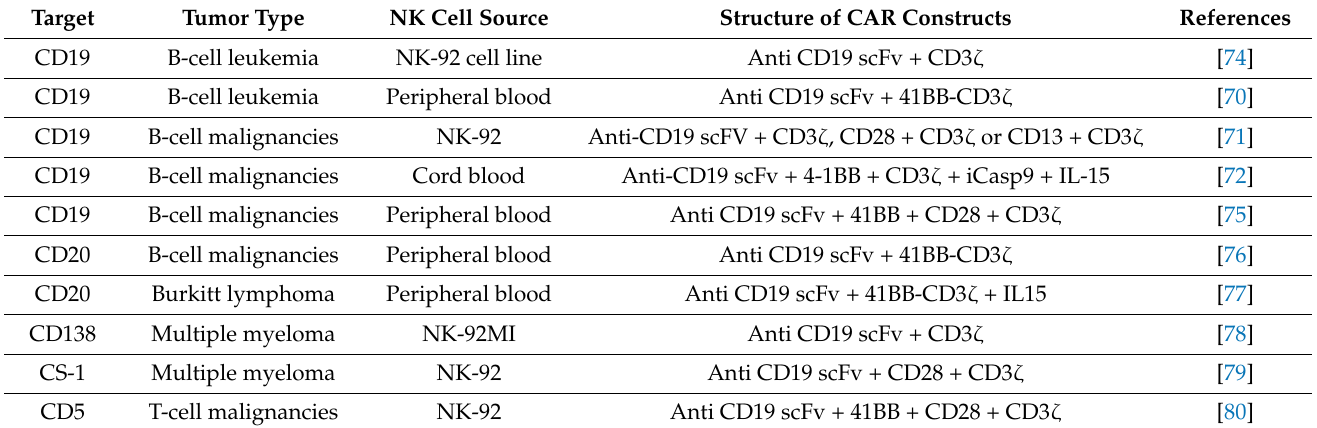
Table 2. Several preclinical studies of CAR-NK cells in hematological malignancies.